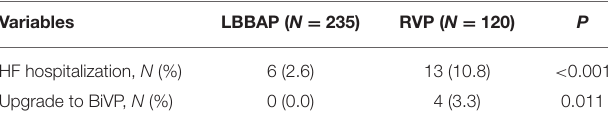
TABLE 4 | Clinical outcomes evaluation.